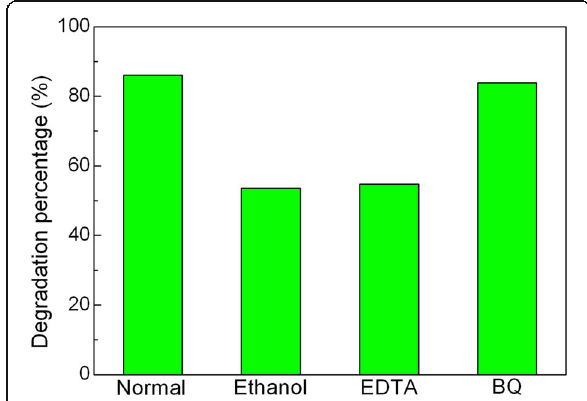
Fig. 11 Effects of ethanol, EDTA, and BQ on the degradation percentage of AO7 over 20wt%Ag 3 PO 4 /BiFeO 3 composite